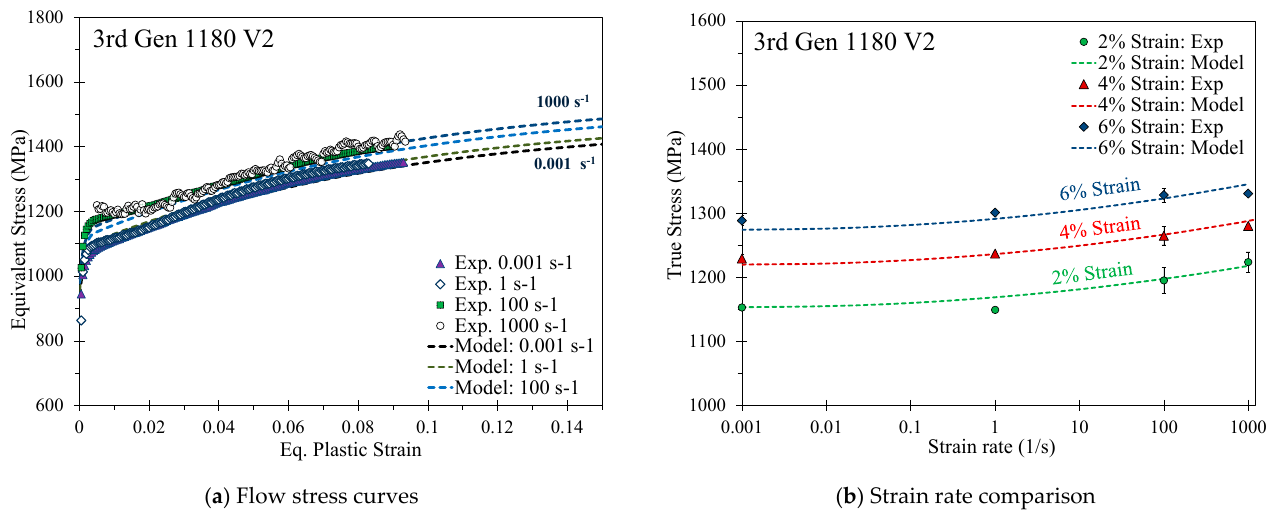
Figure 13. Calibrated modified Cowper Symonds rate-dependent constitutive model for the 3rd Gen 1180 V2. Strain-rate effects for the DP980 steel were studied in Zhumagulov et al. [37] and calibrated using the modified Cowper–Symonds model in Equation (12) and the coeffi- cients in Table 7. Table 7. Calibrated coefficients for the rate-dependent constitutive model in Equations (7) and (8). Note that a reference strain rate of 0.001 s − 1 was adopted.